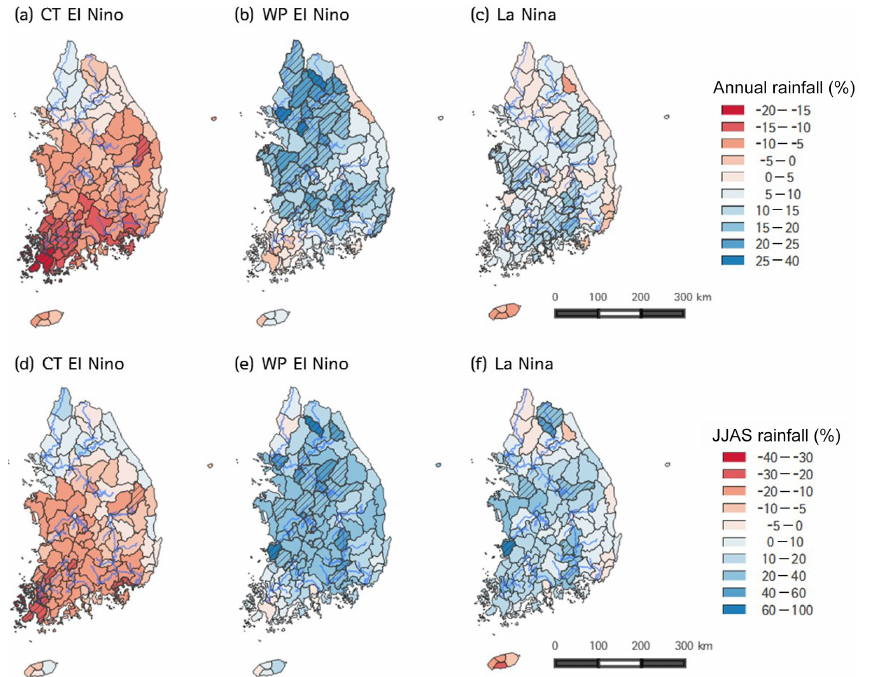
Figure 5. Composite anomalies of annual and JJAS (June to September) rainfall during CT/WP El Niño and La Niña years. The hatched polygons indicate statistically significant changes in annual rainfall based on the 10% significance level.